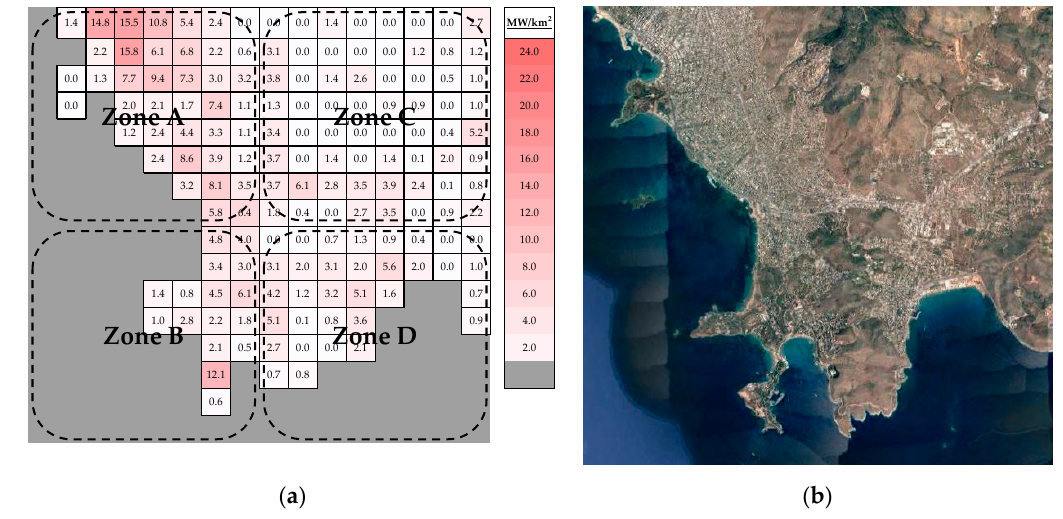
Figure 4. ( a ) Actual load density in year 1999 (base year); ( b ) Aerial view of the service territory.